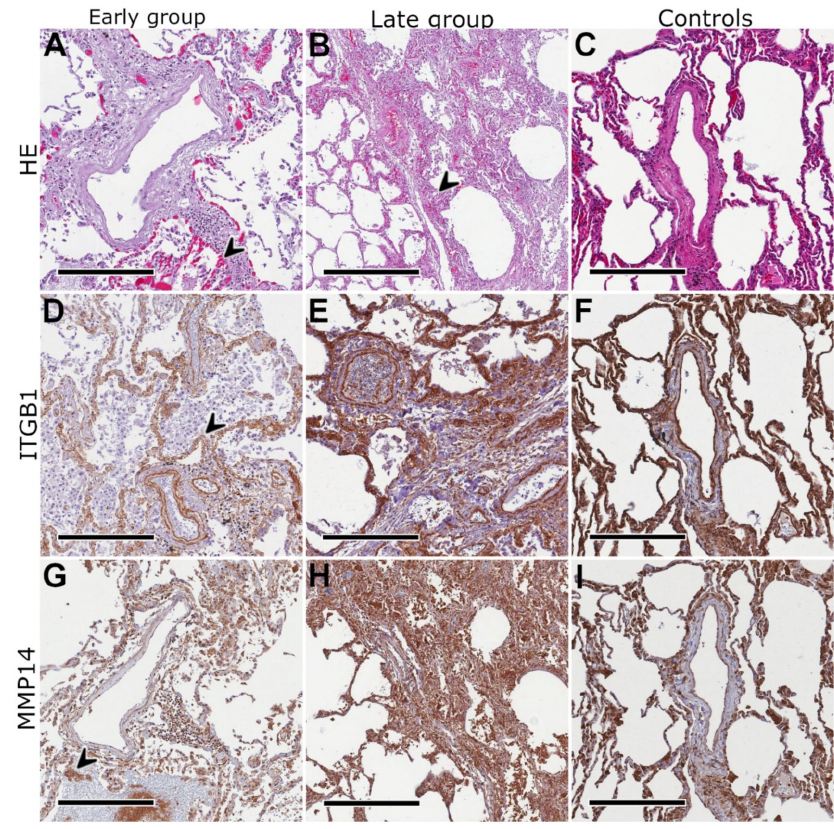
Figure 3. Immunostaining I. Exemplary histological morphology using hematoxylin-eosin (HE) staining in a patient who succumbed to COVID-19 3 days after hospital admission ( A ) showing a perivascular lymphocytic infiltrate and focal hyaline membranes/intraalveolar fibrin deposits (arrow) in line with diffuse alveolar damage; to compare, ( B ) shows another patient who died 14 days after hospitalization due to COVID-19 with intra-alveolar mesenchymal proliferation (arrow) and adjacent thickened alveolar septae indicating a pattern of acute fibrinous organizing pneumonia; ( C ) healthy lung tissue that was donated, but not used for lung transplantation; integrin subunit beta 1 (ITGB1) showed a specific but moderate staining of the internal and external elastic lamina of pulmonary artery branches as well as alveolar basement membranes (arrow) in the early group ( D ); in the late group, ITGB1 was enhanced in the same structures but in comparison to ( E ) these structures appeared distinctly thickened resulting in a higher staining intensity; matrix metalloproteinase 14 (MMP14) showed a broad but moderate staining of several extracellular matrix (ECM) structures in the early group ( G ) compared with an extensive high intensity enrichment in ECM structures in the late group ( H ); compared to the autopsy samples, staining appeared more intensive in healthy controls ( C , F , I ), presumably due to the higher tissue integrity; scale bars equal 300 µ m in all panels except for ( B ) and ( H ) (500 µ m